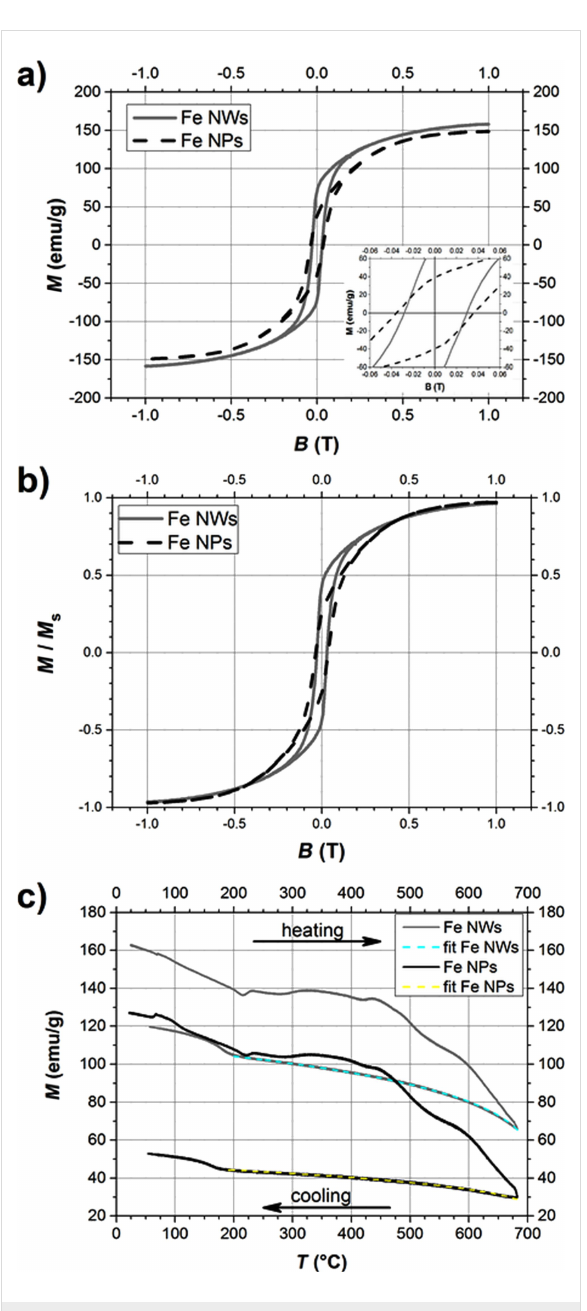
Figure 6: a) Magnetization hysteresis loops of iron nanowires and nanoparticles at room temperature (Inset – magnification of hysteresis); b) Normalized magnetization hysteresis loops of both studied nanostructures; c) Magnetization as a function of temperature curves recorded for iron nanowires and nanoparticles at magnetic field of 0.6 T (grey and black lines correspond to iron nanowires and